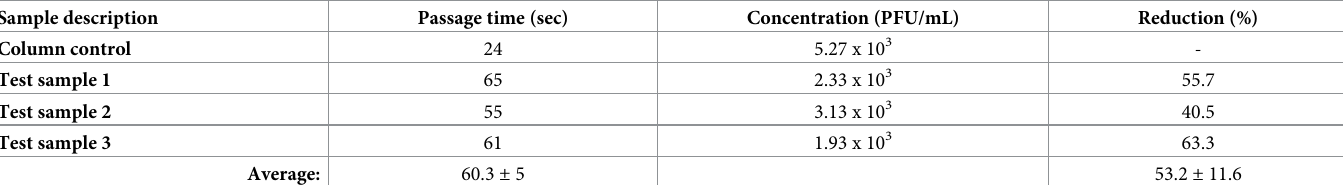
Table 8. NR-55691: Isolate hCoV-19/USA/CA-VRLC086/2021 (Lineage AY.1; Delta Variant). Sample description